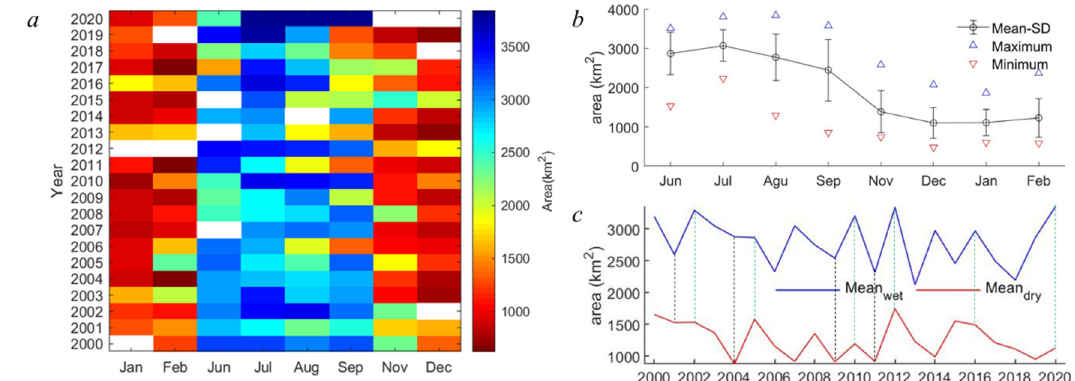
Figure 5. Inundation dynamics of Poyang Lake in the wet and dry seasons from 2000–2020 ( a ), and its seasonal ( b ) and yearly ( c ) variations. A white rectangle in ( a ) indicates that the data is not available for this month. The green and black dotted lines in ( c ) separately indicate wet and dry years, as the values in the wet and dry seasons were both local maximums (wet years) or local minimums (dry years).